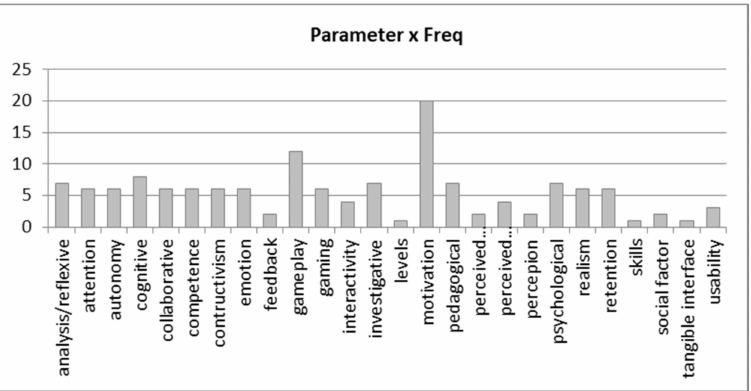
Figure 1. Parameters used in works and their